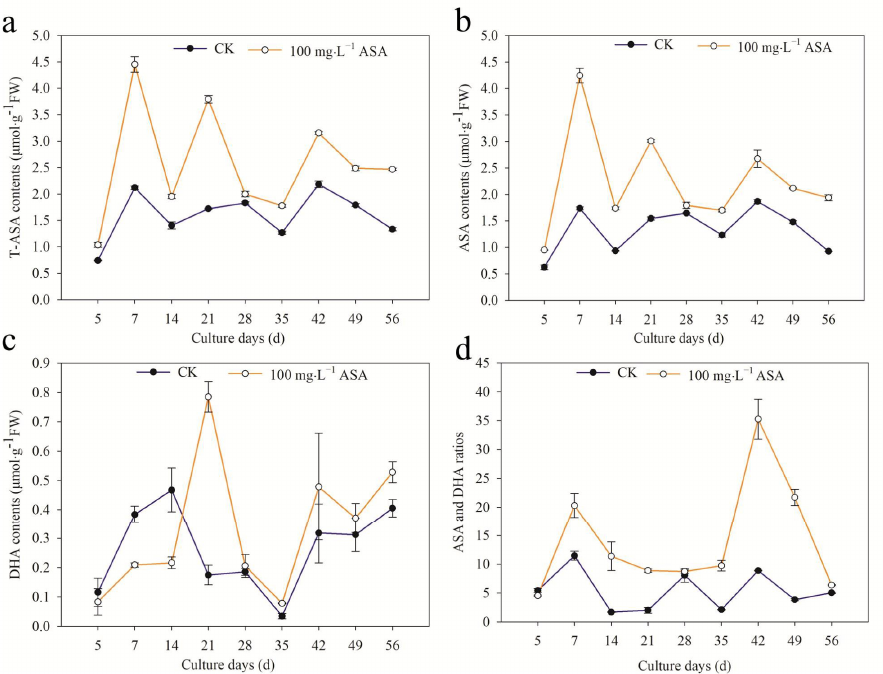
Figure 8. Effects of 0 and 100 mg · L − 1 ASA treatments on ASA synthesis during somatic embryogenesis of Fraxinus mandshurica provenance 3. The x -axis represents the culturing days, the y -axis represents the T-ASA content ( a ), ASA content ( b ), DHA content ( c ), and ASA/DHA ratio ( d ), and the error bar shows the standard error of the mean.